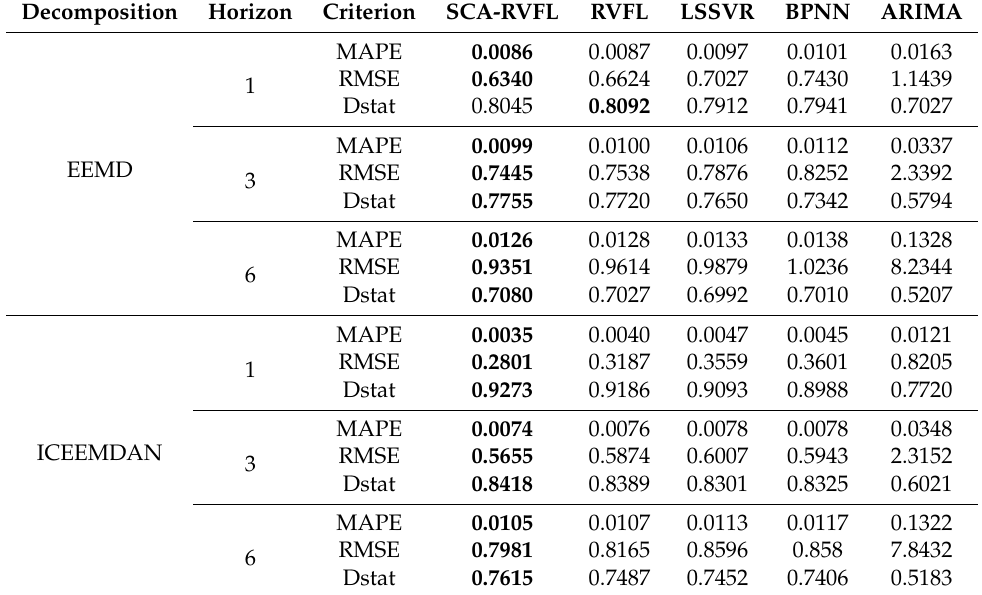
Table 4. Results of ensemble